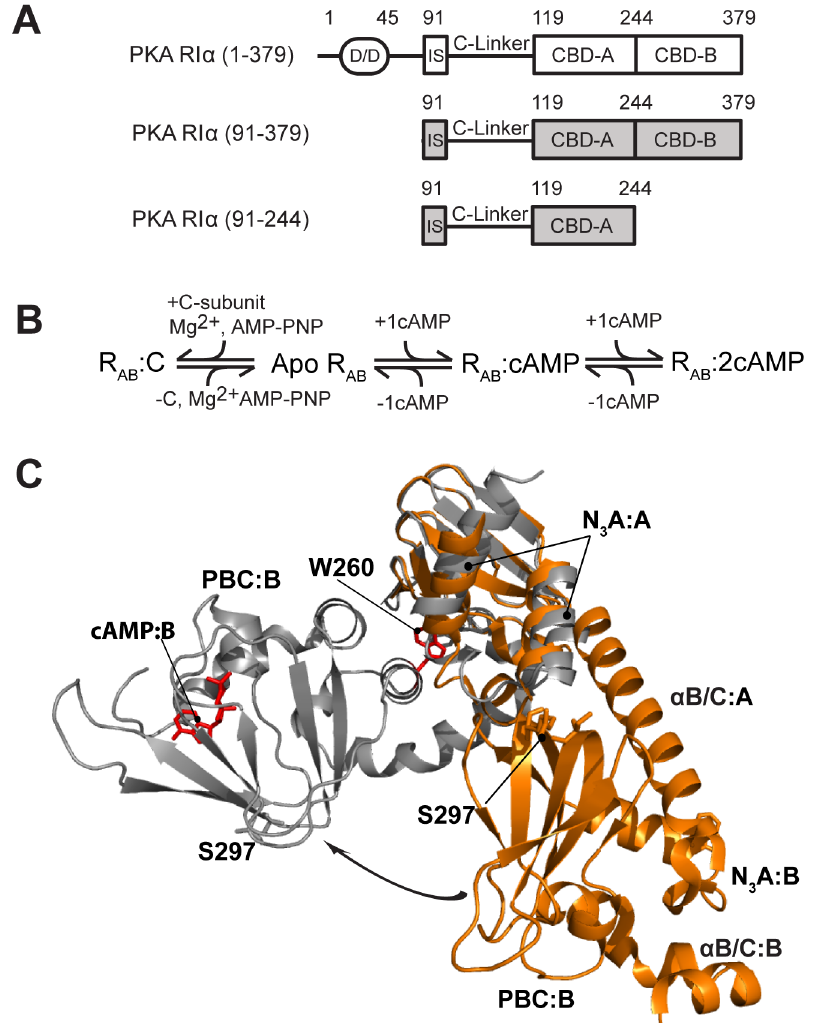
Fig 1. Construct design and architecture of PKA RI α . (A) Domain organization of the RI α subunit of PKA and its functional constructs that ensure cAMP-dependent inhibition of the catalytic subunit (C). (B) Binding equilibria of PKA RI α . Even when apo RI α is a transient low-population intermediate, it is still a critical thermodynamic determinant of the cAMP-dependent regulation of PKA. (C) Structures of PKA RI α (91 – 379) bound to either cAMP (grey, PDB code 1RGS) or the C-subunit (orange, PDB code 2QCS for the R333K mutant of RI α (91 – 379)). The two structures are superimposed through the β -barrel of cAMP-binding domain (CBD) A. Selected regions and residues are labeled. The arrow shows the change in the position of CBD-B relative to CBD-A occurring upon cAMP-binding.